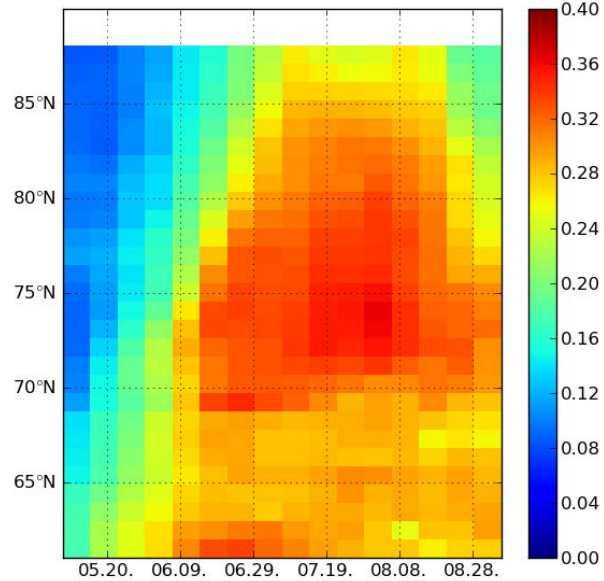
Fig. 7. Zonal mean melt pond fraction per grid cell over the entire Arctic Ocean from